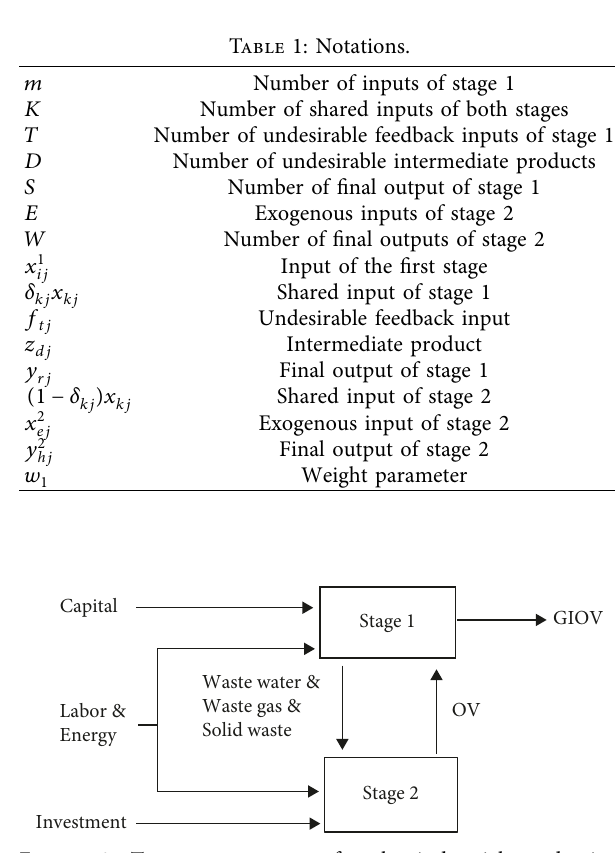
Figure 2: Two-stage structure for the industrial production